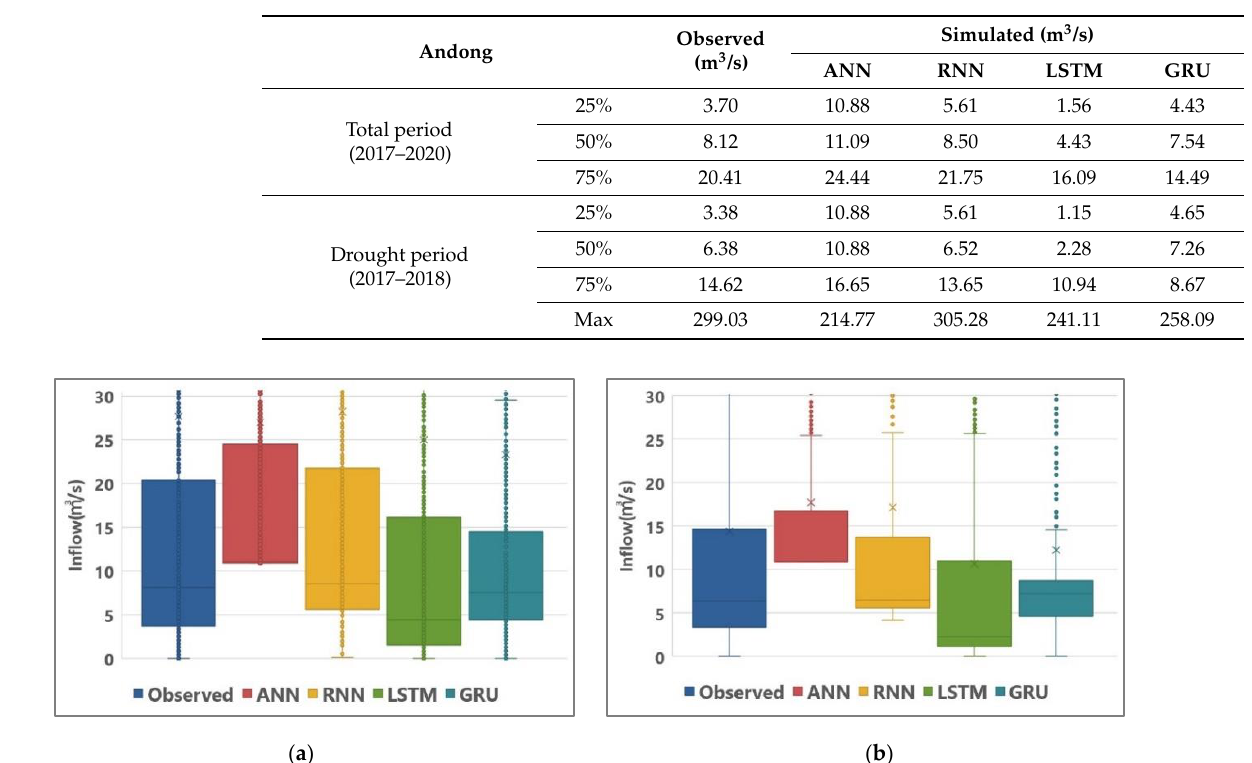
Table 7. Inflow prediction by period at Andong Dam.